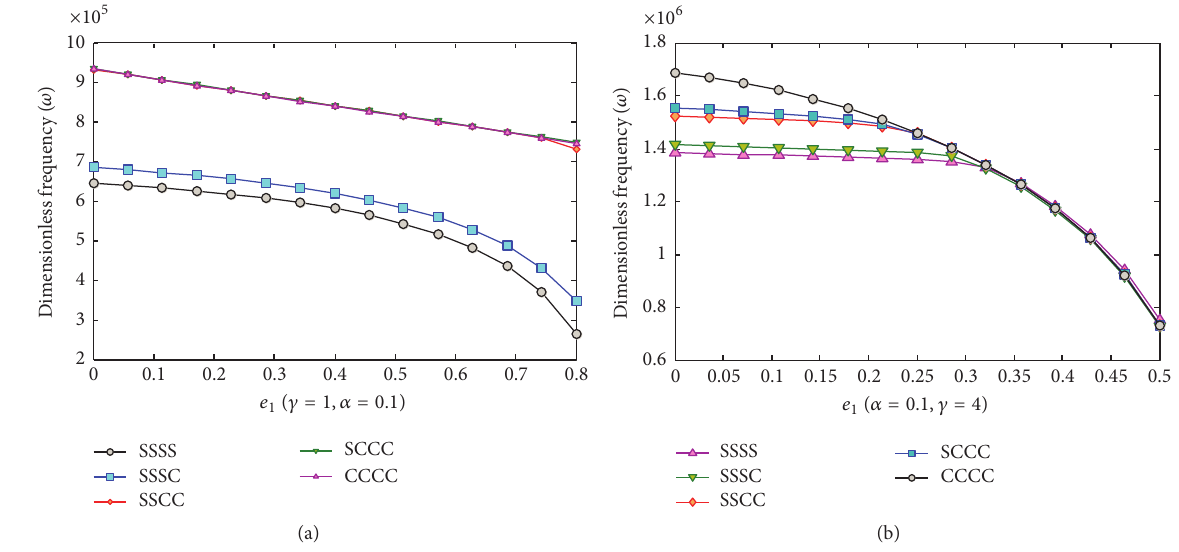
Figure 4: Effect of boundary conditions on dimensionless natural frequency.